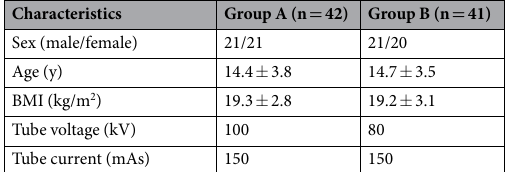
Table 1. Patient characteristics and radiation doses among the two groups. * Significant differences between the group comparison; Abbreviations: BMI, body mass index.